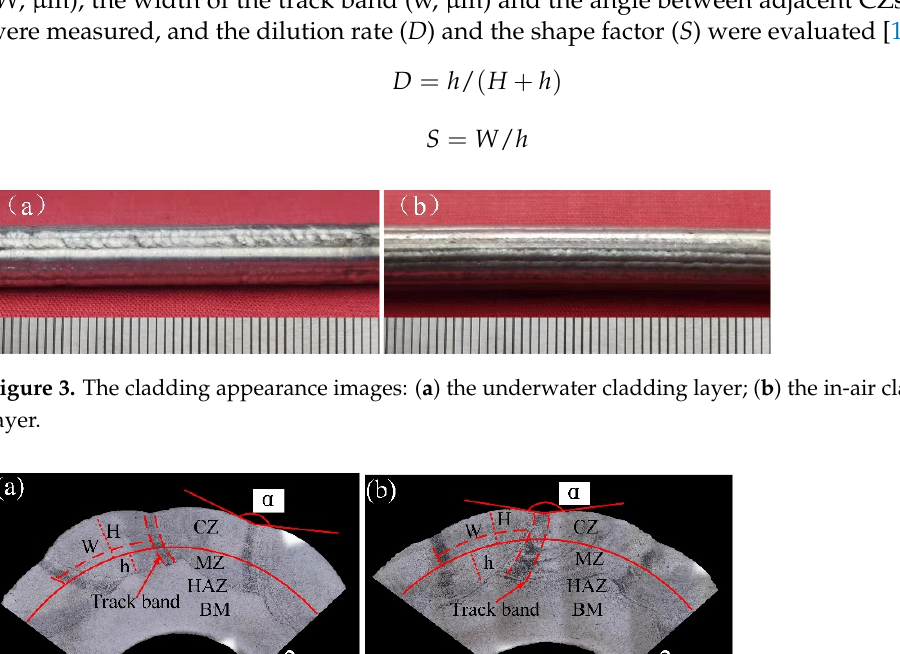
Figure 5. The cross-sectional dimensions of the in-air and underwater cladding tracks. 3.3. Microstructure Figure 4a,b show the cross-section macrostructure of in-air and underwater multiple- track cladding layers, and the microstructure of in-air and underwater samples extracted from different areas and captured by the optical microscope is displayed in Figures 6 and 7. When the laser was used to irradiate the surface of the substrate and wire, a molten pool formed in the substrate and solidified after the laser beam was removed. During the so- lidification process of the molten pool, the grain growth direction mainly depended on the temperature gradient (G), while the grain morphology was determined by the tem- perature gradient (G) and the grain growth rate (R) [27]. Figure 6a shows the microstruc- ture near the fusion line of the in-air multiple-track laser cladding sample. One side of the fusion line was the HAZ, and the other side was the MZ. Due to the effect of the high temperature of the molten pool, the grains near the fusion line grew, and thus the micro- structure in the HAZ was relatively coarse equiaxed grains. The rapid loss of heat through